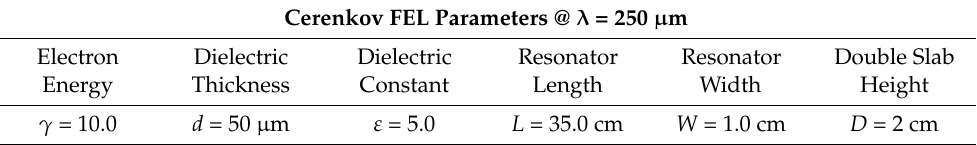
Table 1. Cerenkov FEL Parameters @ λ = 250 µ m.